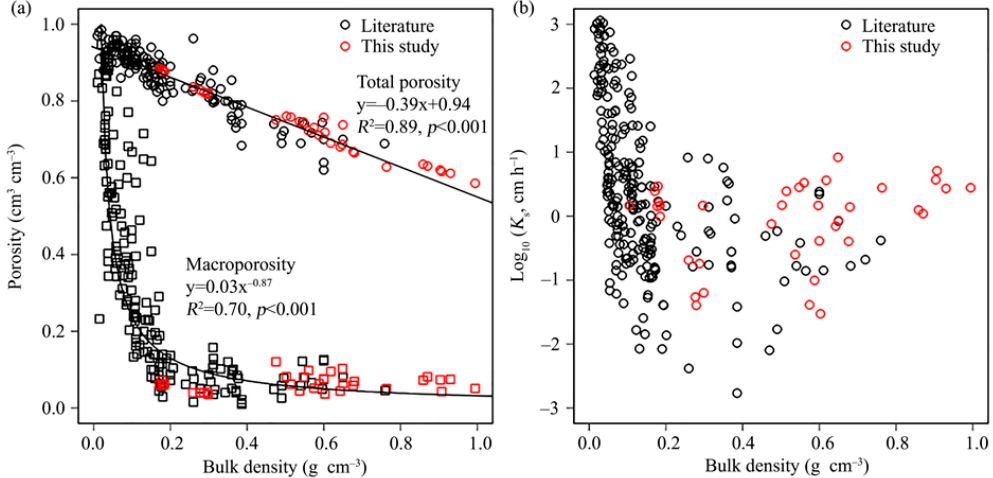
Figure 10. Relationships between soil hydraulic variables as derived from extensive meta-analysis of the literature (black) and from our own measurements in the WETSCAPES study sites: ( a ) Porosity vs. bulk density with separation of micropores (squares) and total pores (circles); ( b ) Saturated hydraulic conductivity (K s ) vs. bulk density. For details on data acquisition and analysis, see [113].